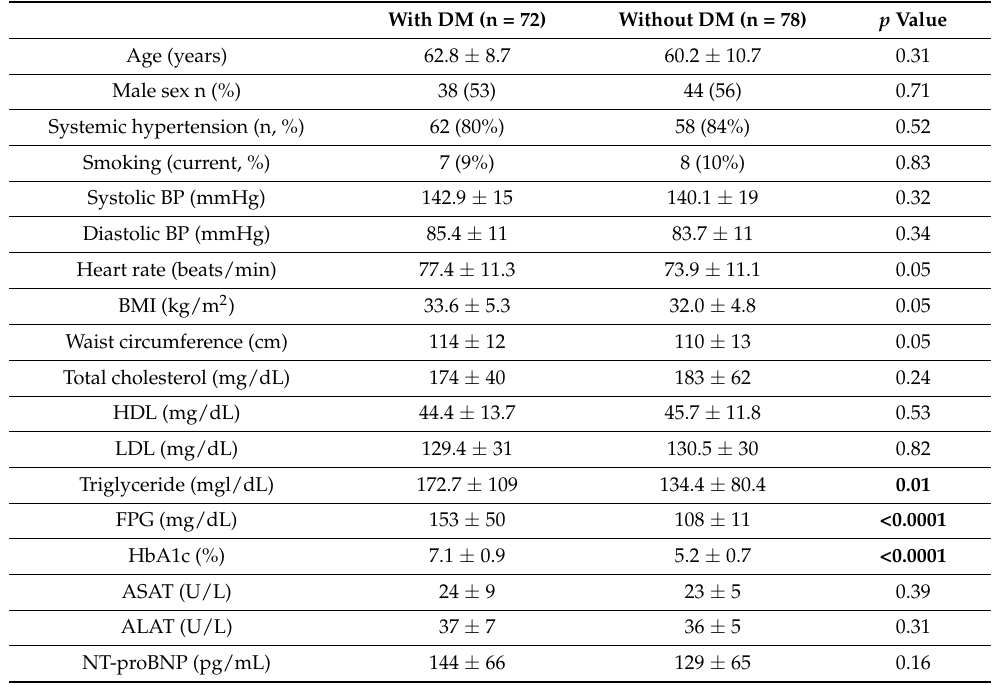
Table 1. Clinical and laboratory features of MetS